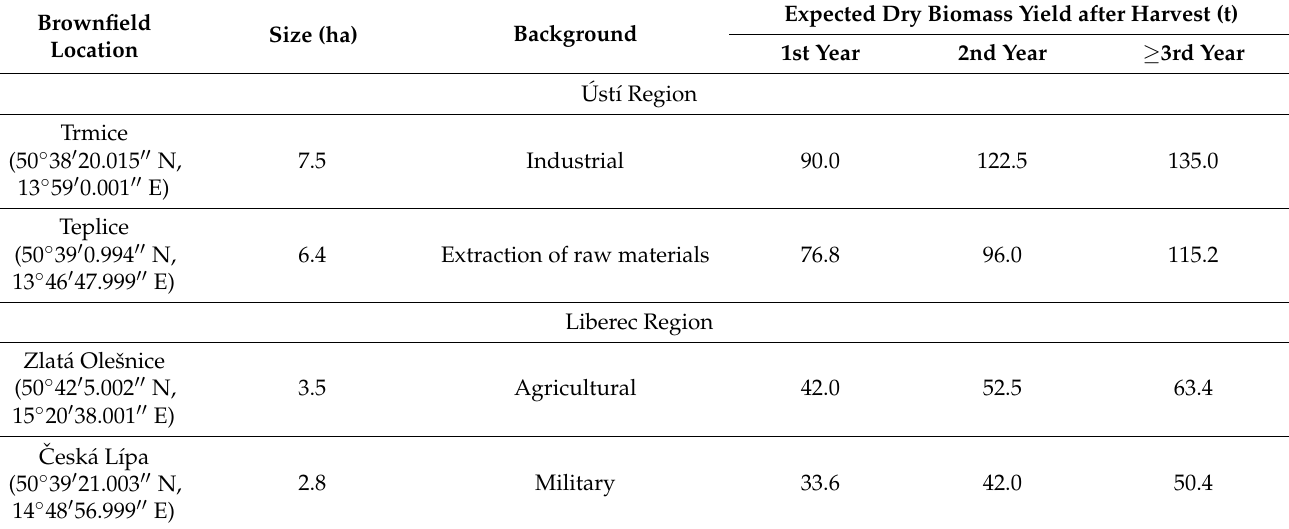
Table 7. Expected Mxg biomass yields when the crops are cultivated on the selected brownfields in the Ú st í and Liberec